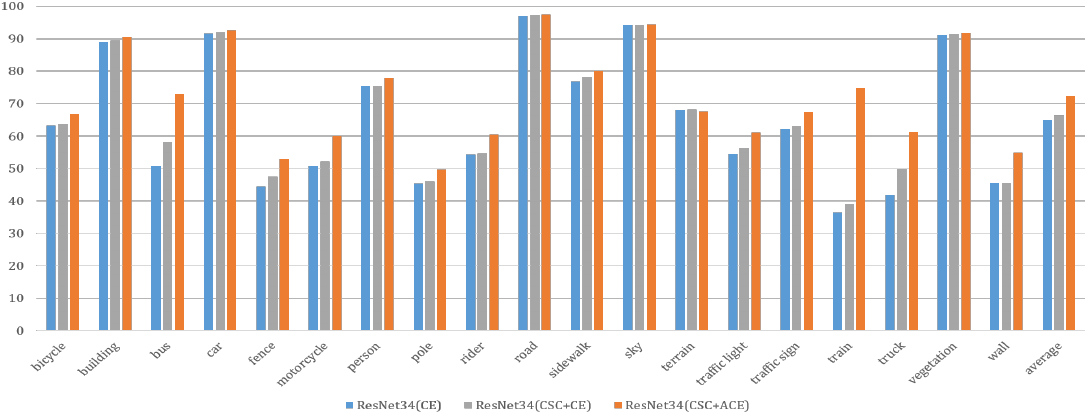
Figure 5. Illustration of the improvement of the accuracy using our distillation method for each class on the Cityscapes test set. We used the Deeplab-V3 + structure with Resnet34 as the encoder for this experiment. The blue bar (baseline) indicates the results without distillation method. The gray bar represents the results using the CSC + CE loss function. The orange bar represents results using the CSC + ACE loss function. The height of the bars represents